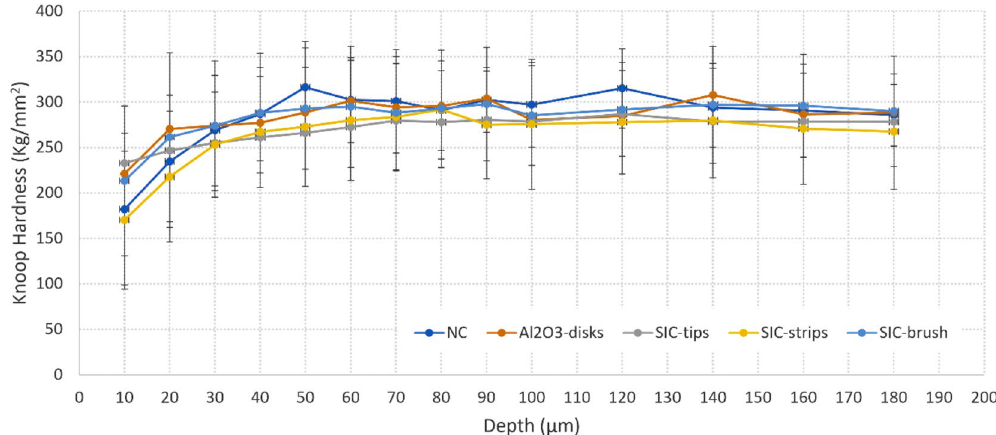
Figure 4. Mean Hardness (kg/mm 2 ) profile of enamel after the intraoral period according to distance (μm) from the surface for the different groups (bars denote SD).